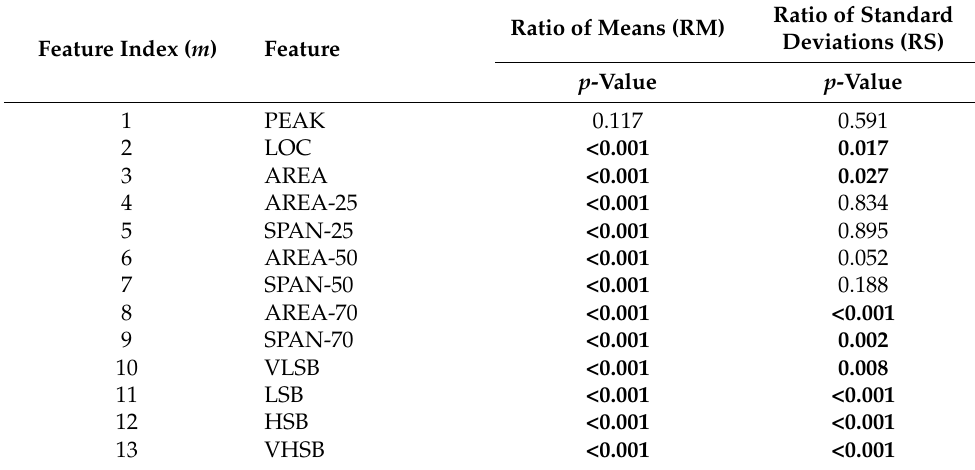
Table 6. Apnea hypothesis testing (bold for p -value < 0.05, N = 693).